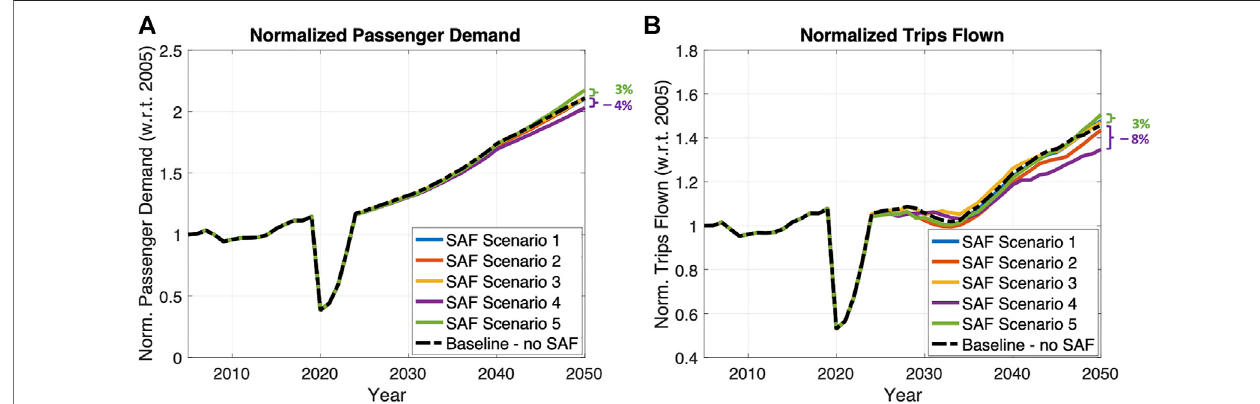
FIGURE 10 | (A) Normalized passenger demand, (B) Normalized trips fl own, for SAF scenarios (considering passenger demand recovery to pre-COVID-19 levels by 2024 and GDP slowdown to 75% until 2030).